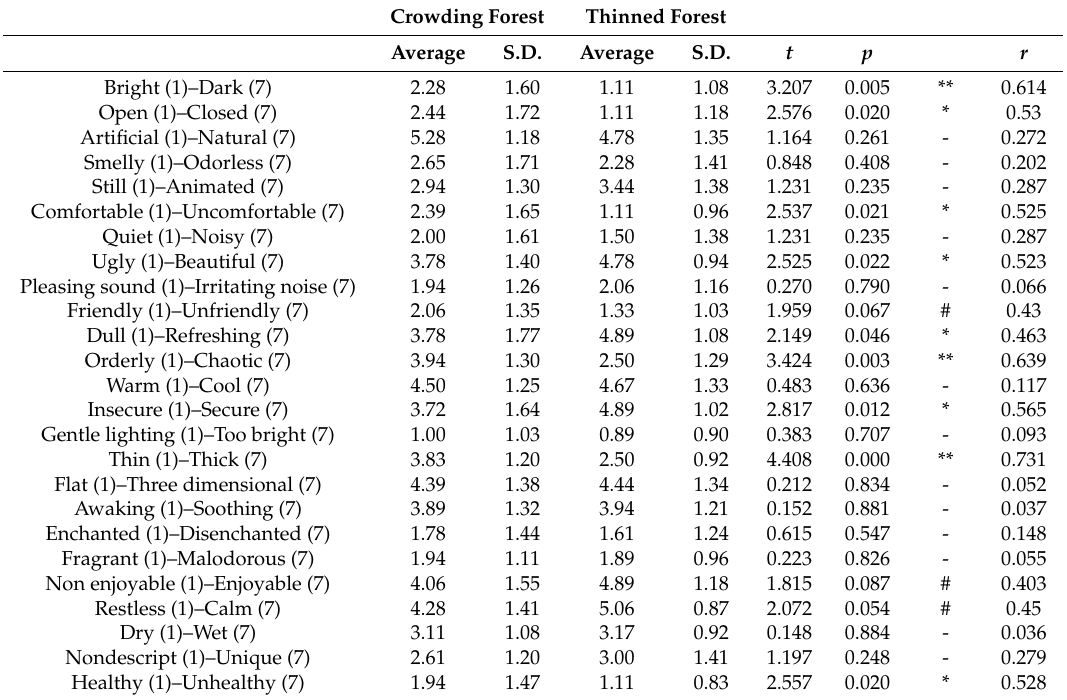
Table 5. T -test results for the comparisons of the crowding and thinned forest settings using the SD scale. Crowding Forest Thinned Forest